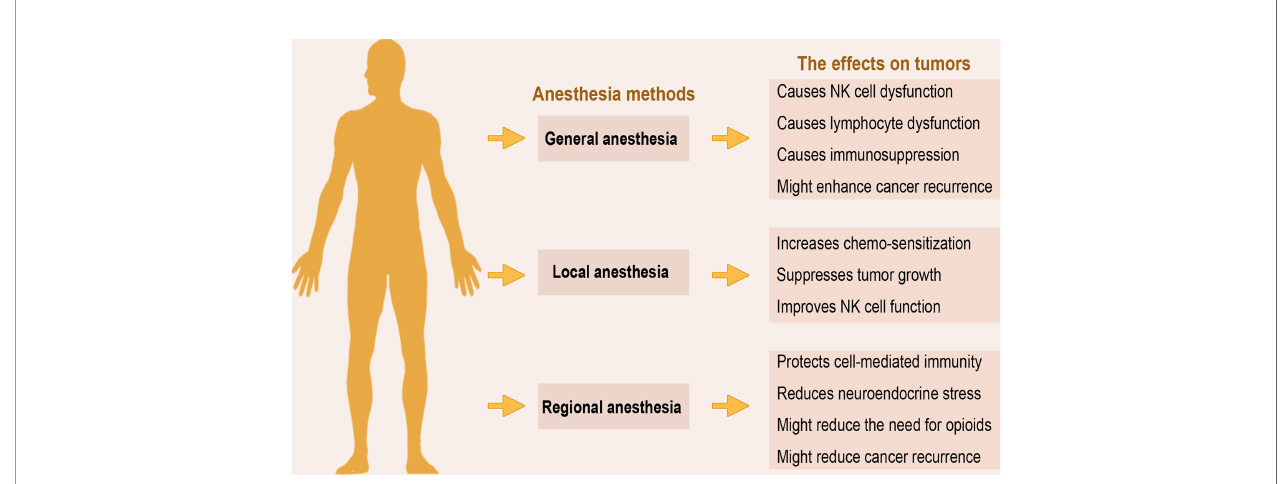
FIGURE 1 | Anesthesia methods and overview of their effects on tumors. The three main anesthesia methods applied in surgery exert varying effects on the host ’ s immunity and ability to clear residual tumor cells. The overview of current data from animal models, in vitro , and human studies, suggests that regional anesthesia may be more preferred to general anesthesia due to its immunoprotective